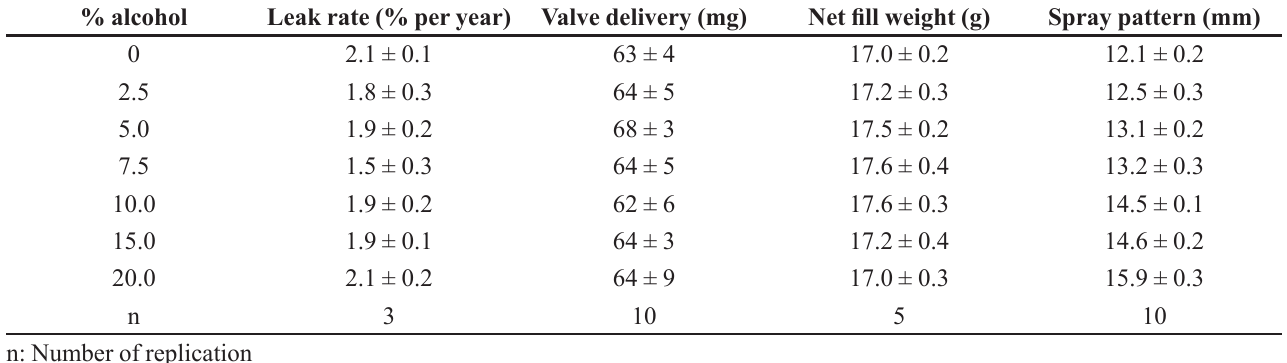
TABLE IV - Characterization of MDI formulated with various concentrations of alcohol % alcohol